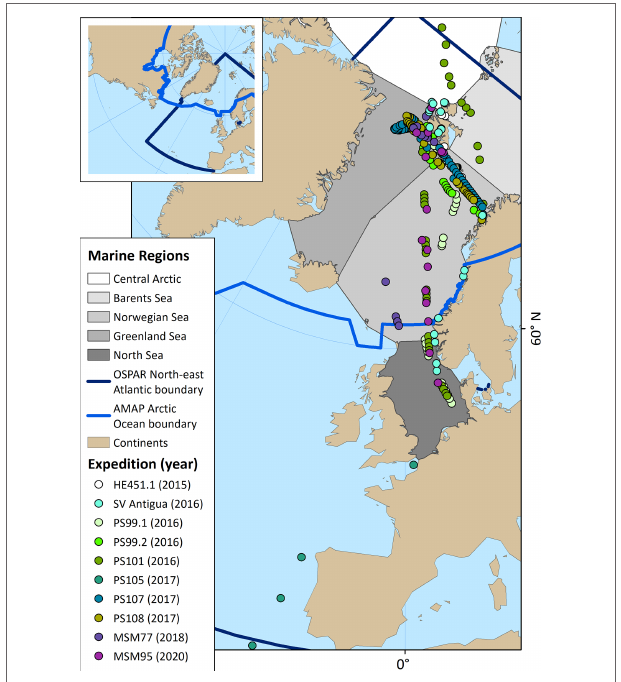
FIGURE 1 | Location of visual surveys conducted in the study area between 2015 and 2020. Each circle corresponds to a visual survey. Marine regions are discerned by different colours. The Arctic Ocean boundary of the Arctic Monitoring & Assessment Programme (AMAP) divides the Arctic waters from the temperate Northeast Atlantic. The close-up map shows the AMAP Arctic Ocean boundary and the OSPAR Northeast Atlantic boundary within the study